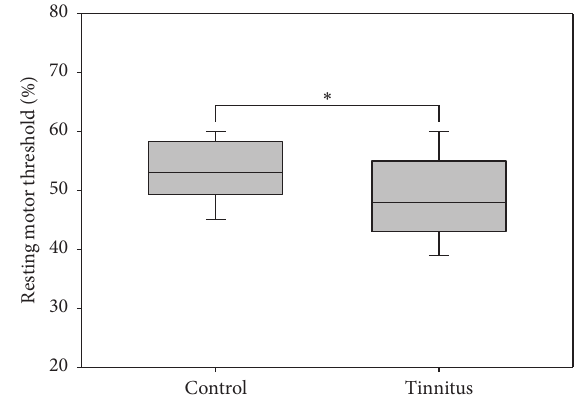
Figure 2: The resting motor threshold was significantly lower in tinnitus patients compared with healthy